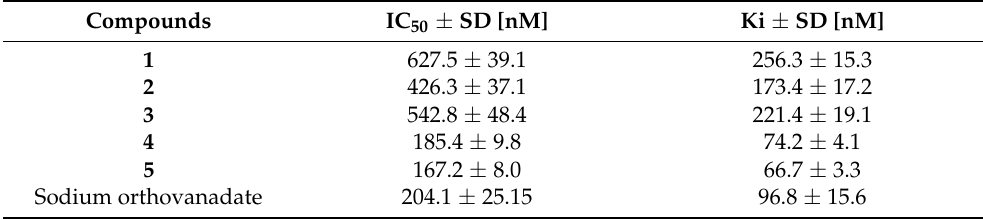
Table 1. IC 50 and Ki values against PTP1B for Compounds 1 – 5 and sodium orthovanadate.